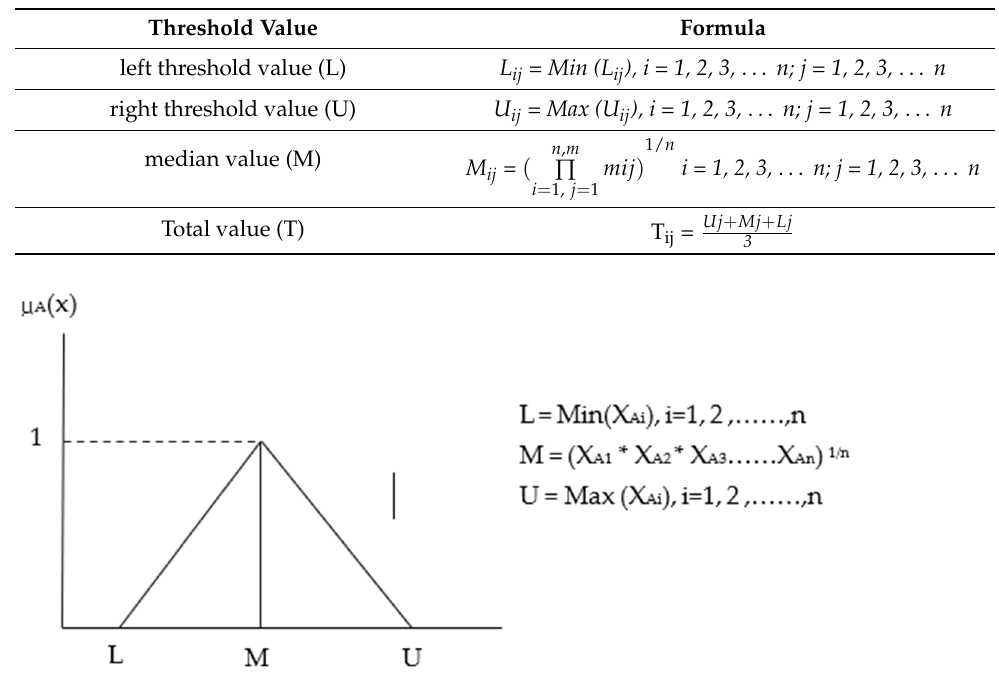
Table 2. Description of triangular fuzzy numbers.